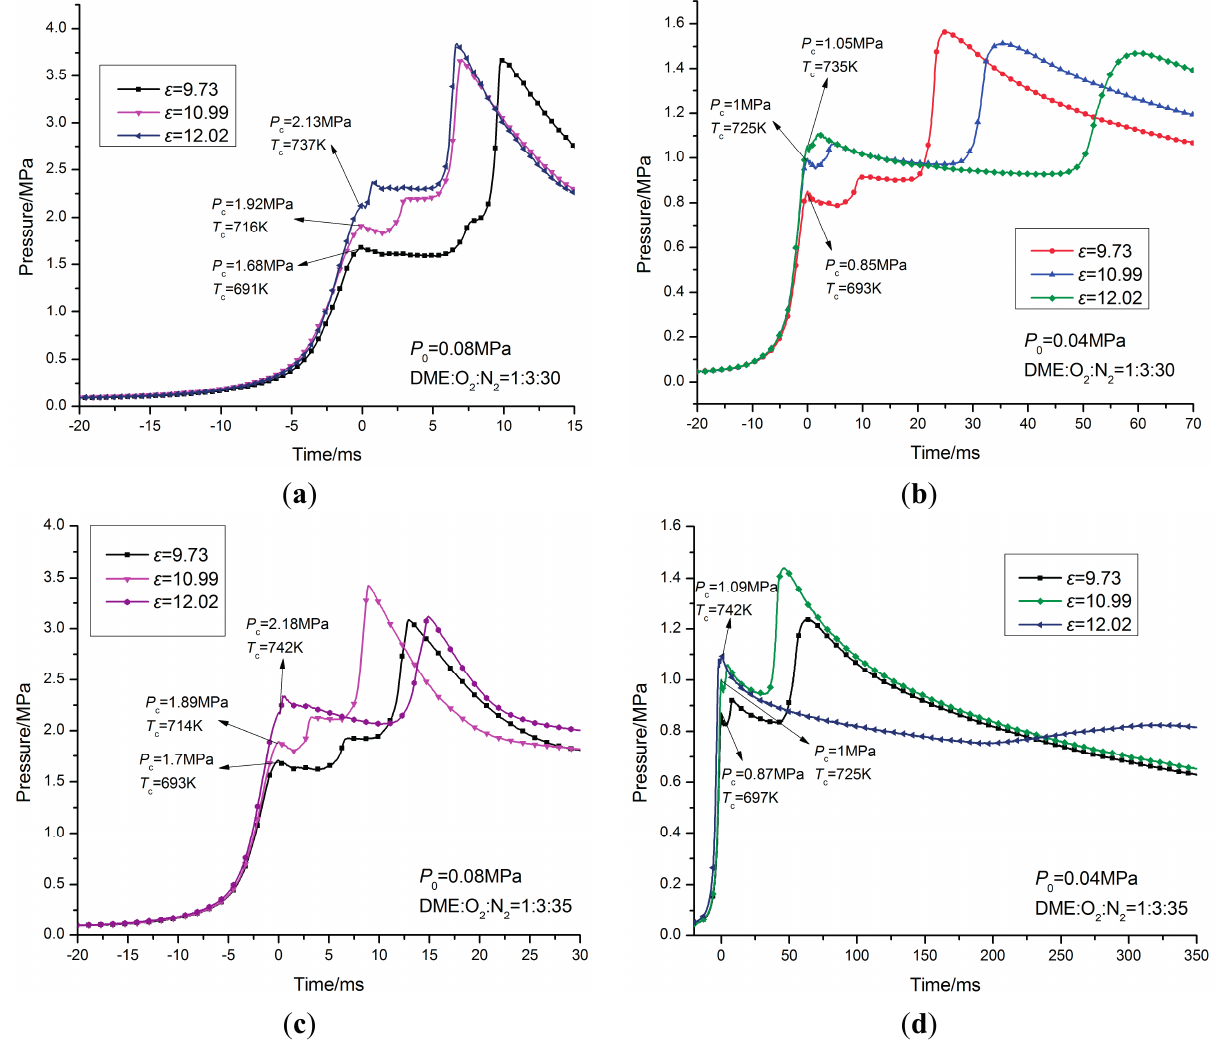
Figure 16. Effect of compression ratio on two-stage ignition delay: ( a ) 55.04% dilution, P 0 = 0.08 MPa; ( b ) 55.04% dilution, P 0 = 0.04 MPa; ( c ) 60.81% dilution, P 0 = 0.08 MPa; and ( d ) 60.81% dilution, P 0 = 0.04 MPa.